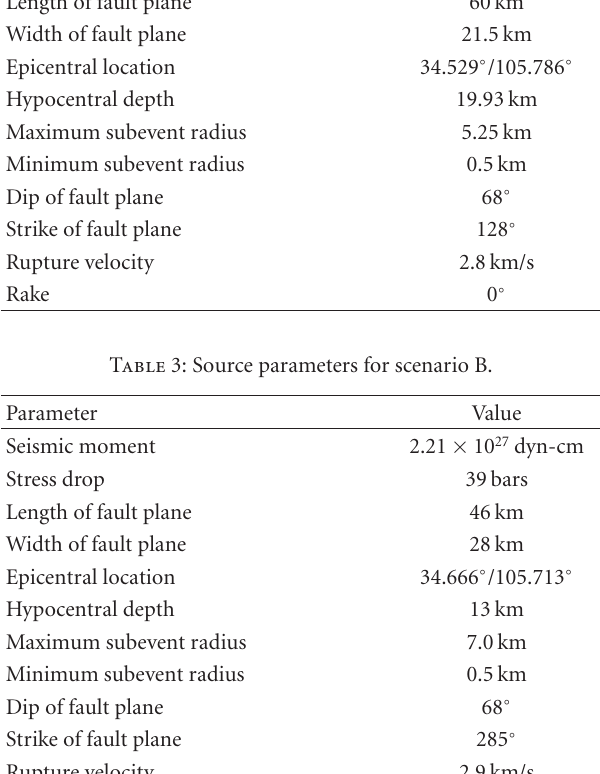
(M9.0), showed that mitigations—better seismic design for buildings, bridges, and other infrastructure—are the most e ff ective way to reduce seismic risk and avoid earthquake disasters. Although development of policy for seismic